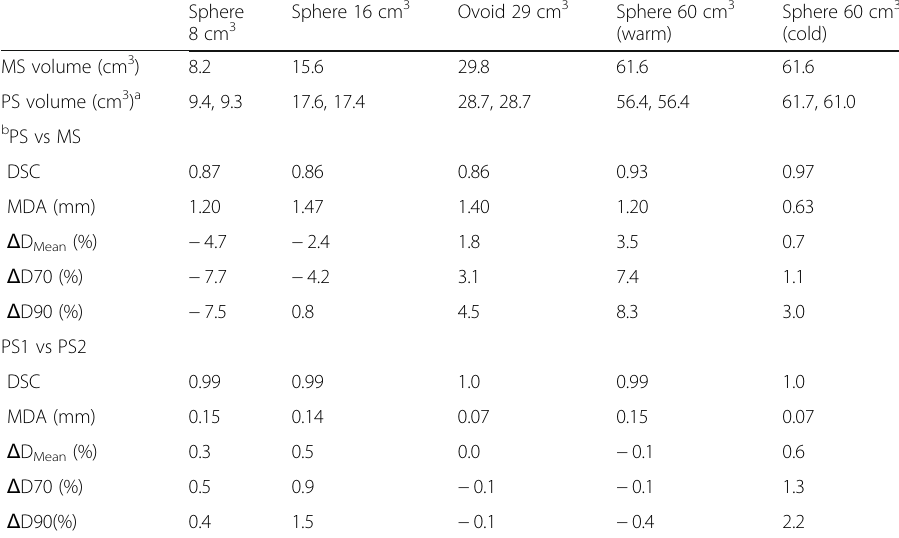
Table 2 Summary of phantom results for the two segmentation methods and the two PS